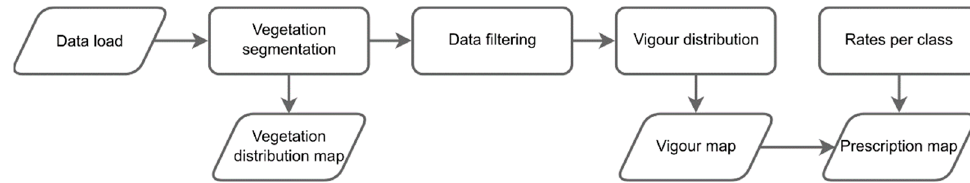
Figure 1. Main steps of the proposed methodology.